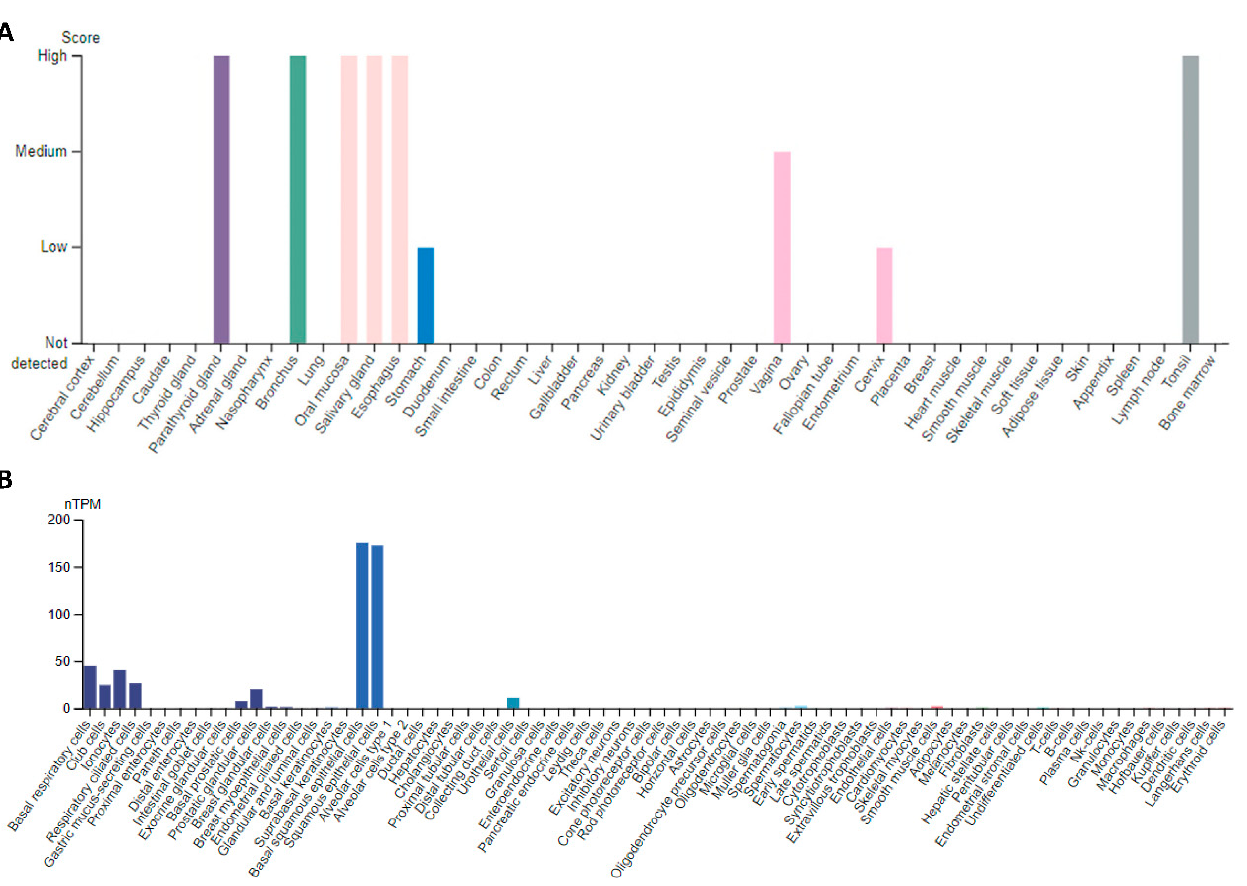
Figure 1. PAX9 expression in human tissues and cells (www.proteinatlas.org) (accessed on 22 March 2022). ( A ) PAX9 protein expression based on immunostaining of tissue sections; ( B ) PAX9 mRNA expression based on single-cell RNAseq data.